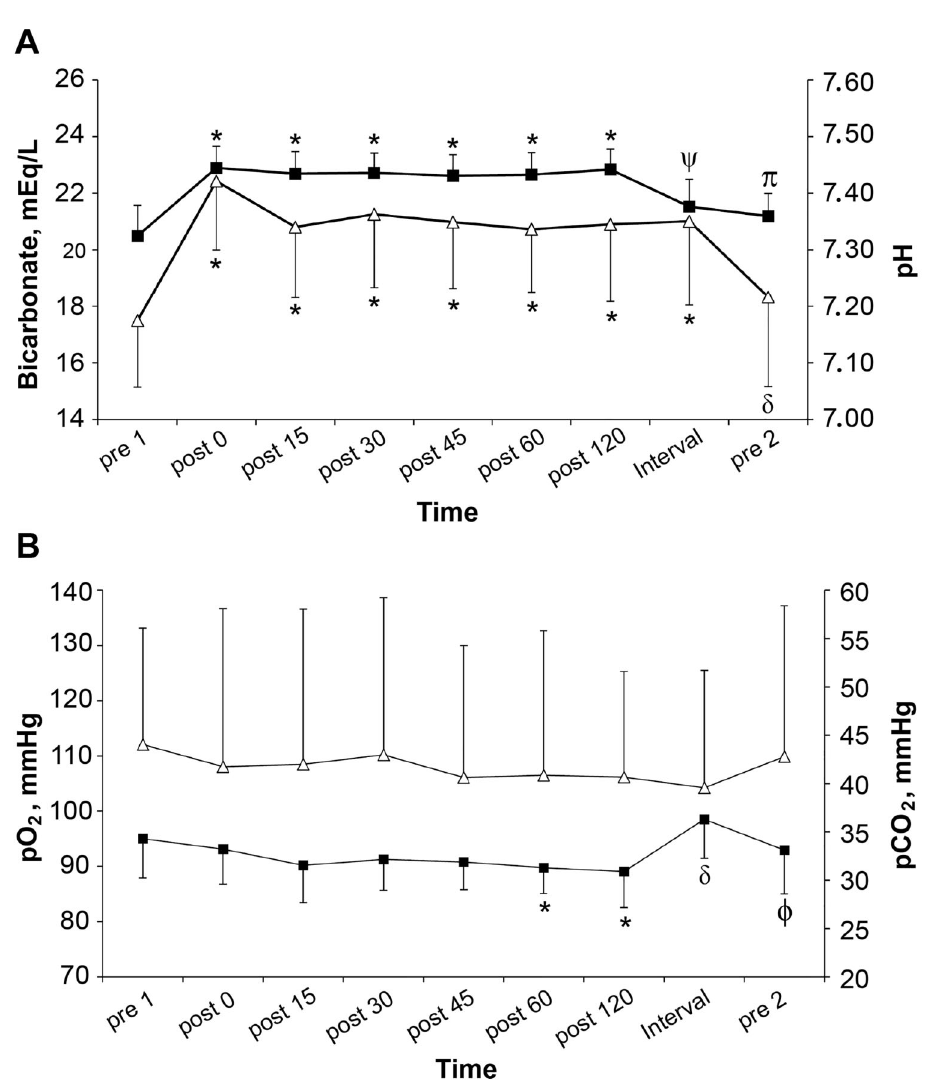
Figure 2. A , Kinetics of bicarbonate (open triangles) and pH (closed squares), and B, of pO 2 (open triangles) and pCO 2 (closed squares). Data are reported as means ± SD. Pre: immediately before the dialysis session (numbers 1 and 2 refer to the 1st and 2nd sessions of the week); post: after the 1st dialysis session of the week (numbers refer to min after the end of the session); interval: 20 h after the end of the fi rst session of dialysis of the week. P o 0.050: * vs pre1; C vs all previous measures; p vs all previous measures